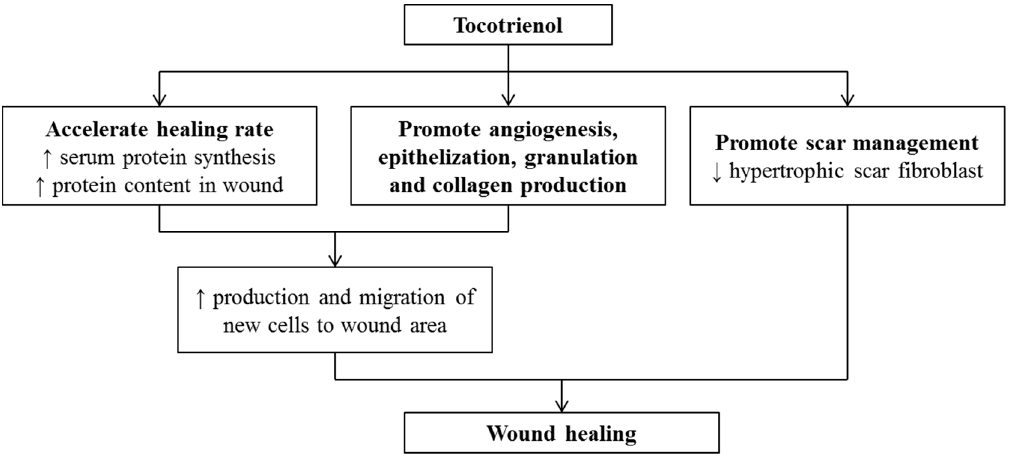
Figure 9. Effects of T3 on wound healing. Figure 9. E ff ects of T3 on wound